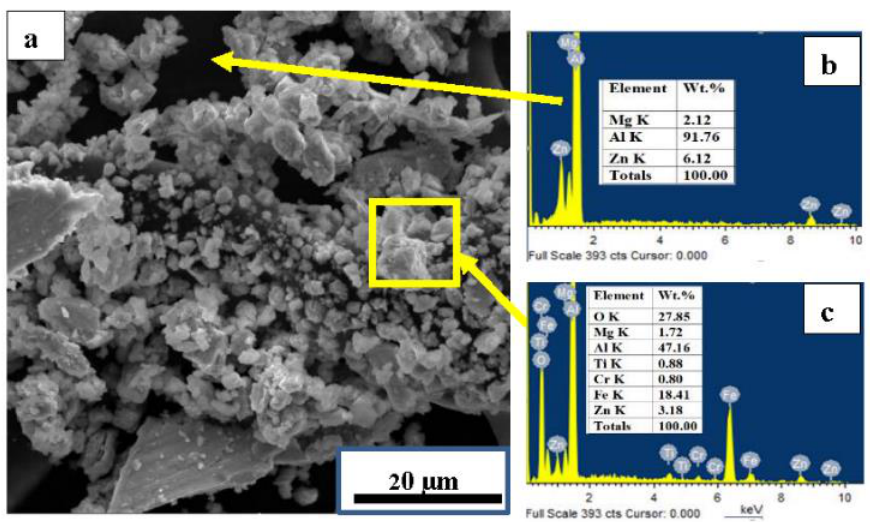
Fig. 15. SEM image and EDS spectrum of the wear debris of Al 7075/TiC